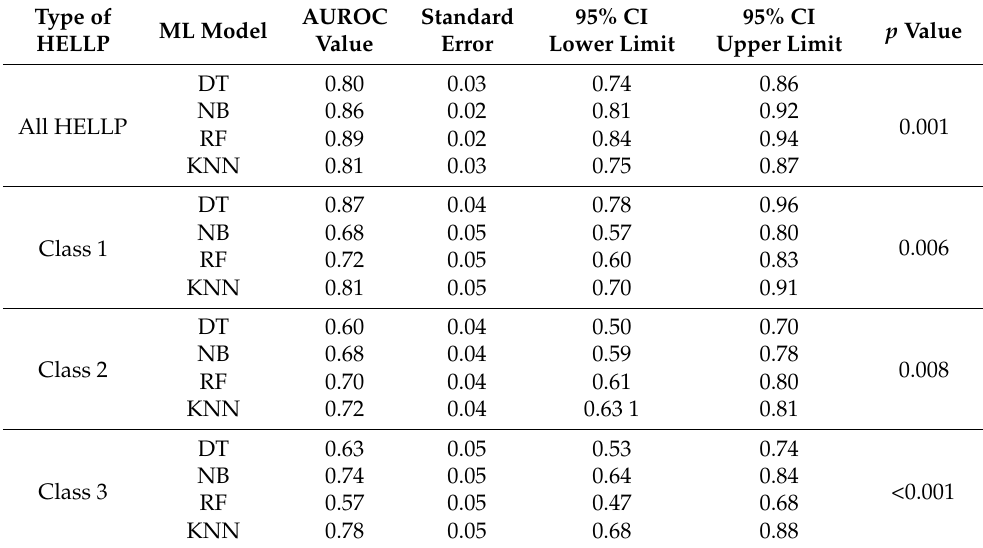
Table legend: All HELLP—all types of HELLP syndrome; ML—machine learning; DT—decision trees; NB—naïve Bayes; KNN—k-nearest neighbors; RF—random forest; AUROC—area under the receiver operating characteristic curve; CI—confidence interval.